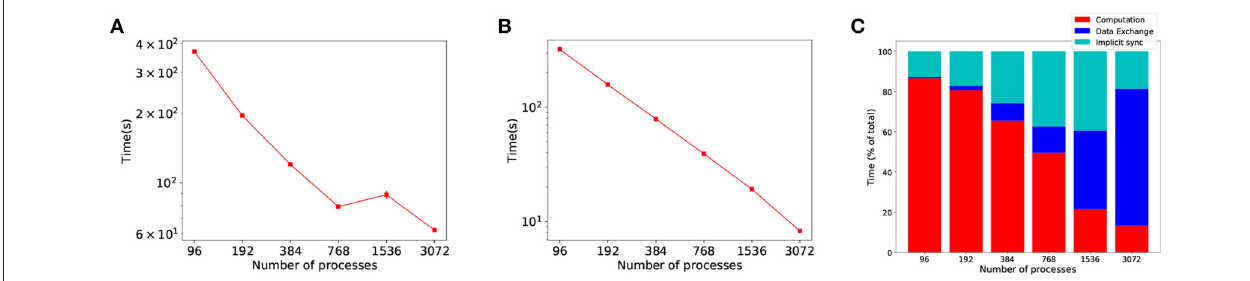
FIGURE 1 | Evidence of the communication problem in large-scale distributed SNN simulations. The graphs show strong scaling results for a simulation with the same communication and computation time step , δ syn (synaptic delay) and τ step (time step) both set to the same value (0.1 ms), which is known to be the worse case scenario in communication. (A) Simulation time as the number of processes is increased. (B) The time the simulation spends in computing. (C) Proportion of time the simulation spent in each phase, with communication (data exchange and implicit synchronization) becoming the dominant